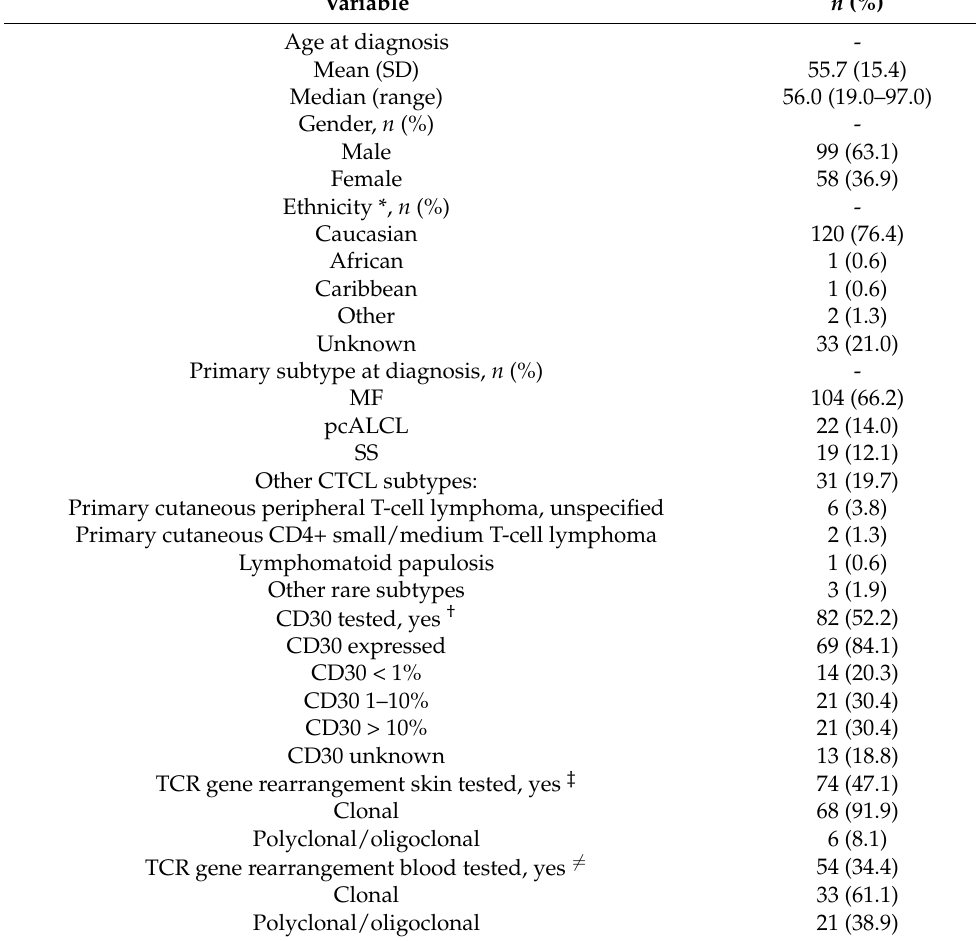
Table 1. Patient demographics and clinical characteristics at diagnosis ( n =